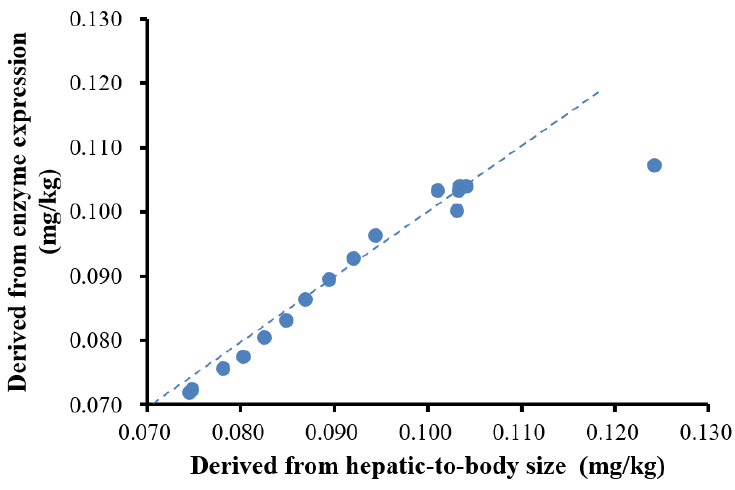
Figure 3. Physiology-based pharmacokinetic (PBPK) predicted dosages derived from the relative liver weight vs. those derived from enzyme expression (1–16 years old).